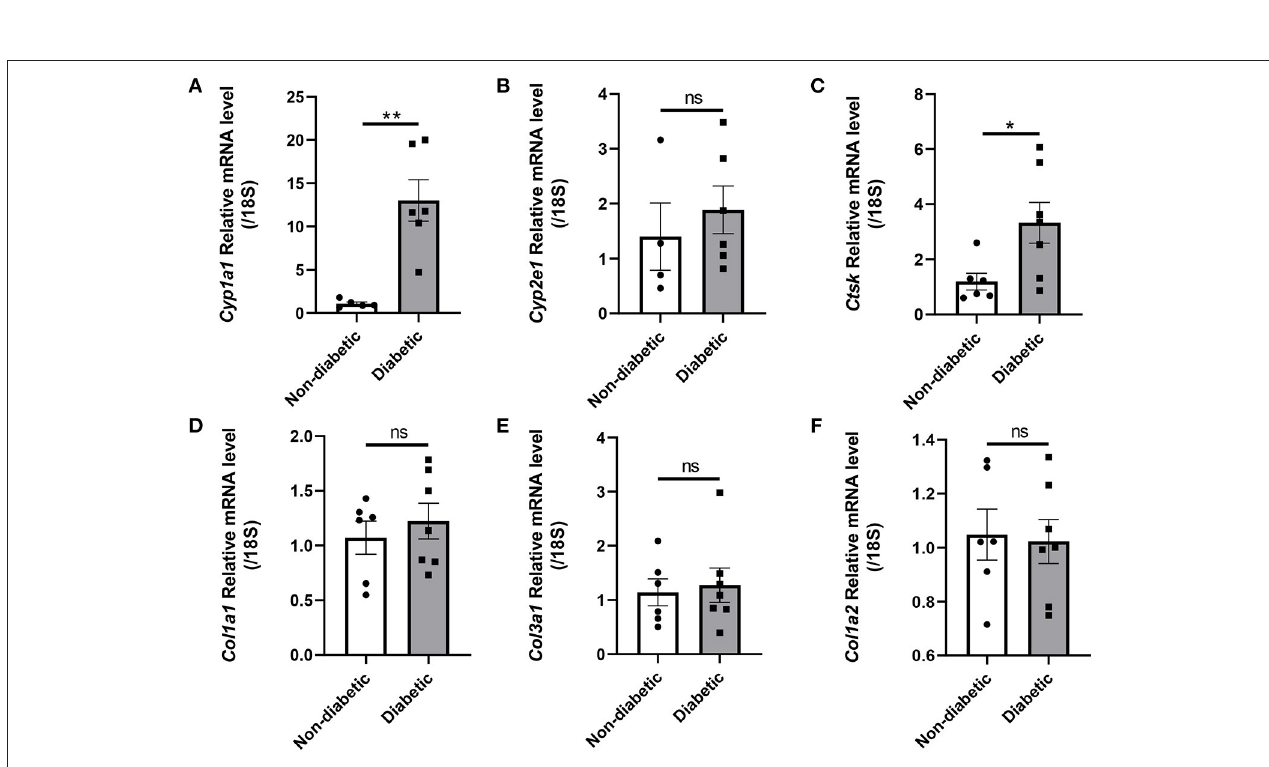
FIGURE 7 | Hub genes and Ctsk expression in the hearts of non-diabetic and STZ-induced diabetic mice. (A) Cyp1a1 mRNA fold change; (B) Cyp2e1 mRNA fold change; (C) Ctsk mRNA fold change; (D) Col1a1 mRNA fold change; (E) Col3a1 mRNA fold change; (F) Col1a2 mRNA fold change. Mean ± SEM, n = 4–7 mice per group. * p < 0.05 and ** p < 0.01 vs. Non diabetic control group. ns, no significance.